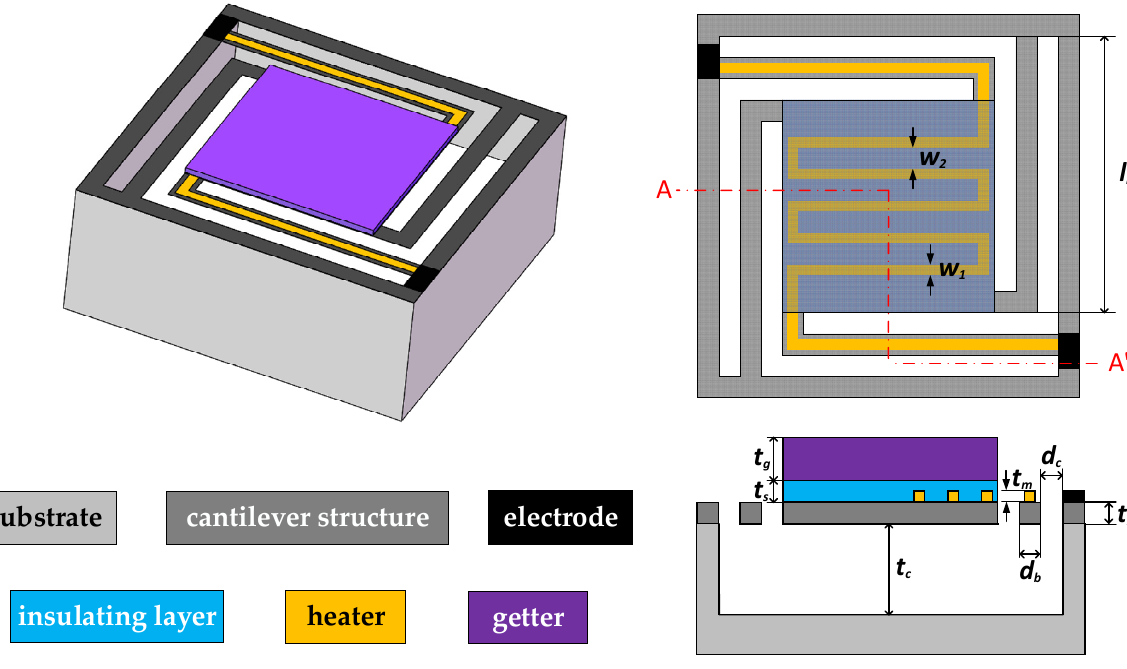
Figure 1. EELC model.